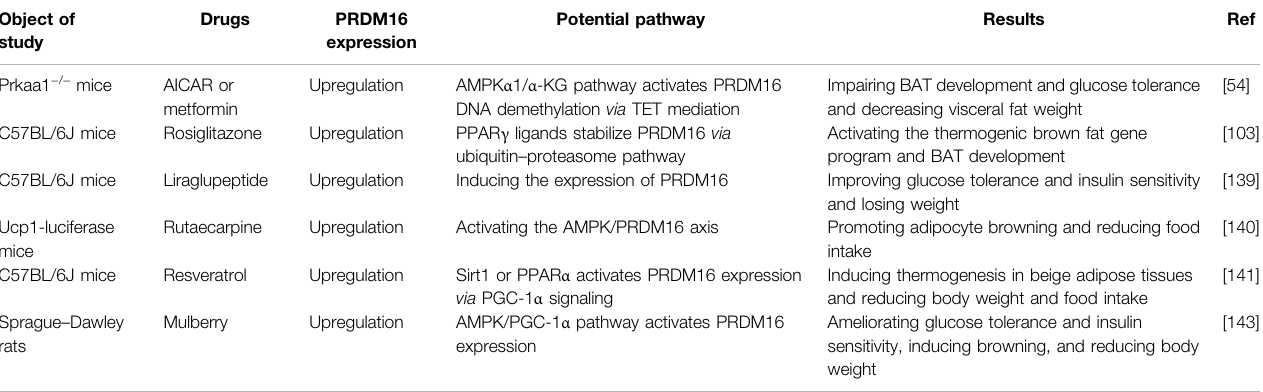
TABLE 1 | PRDM16 signaling may have antiobesity and antidiabetes effects. Object of